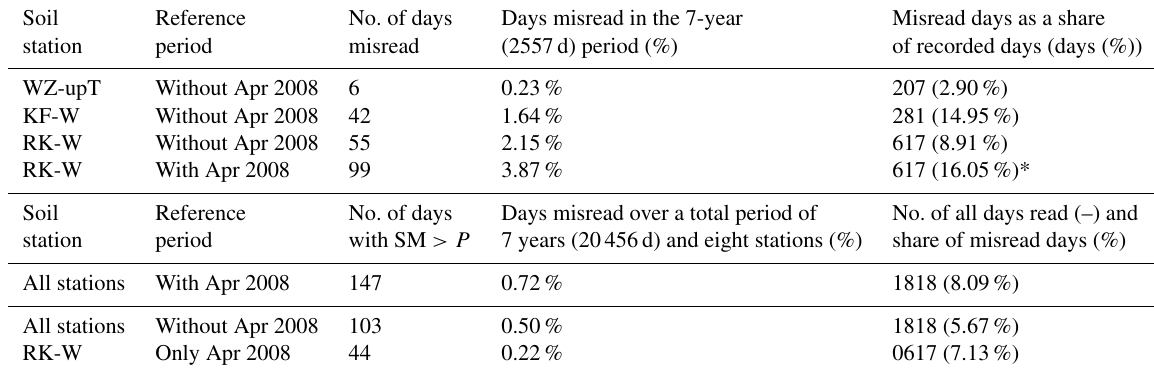
Table B2. Periods and shares of days with misreadings.